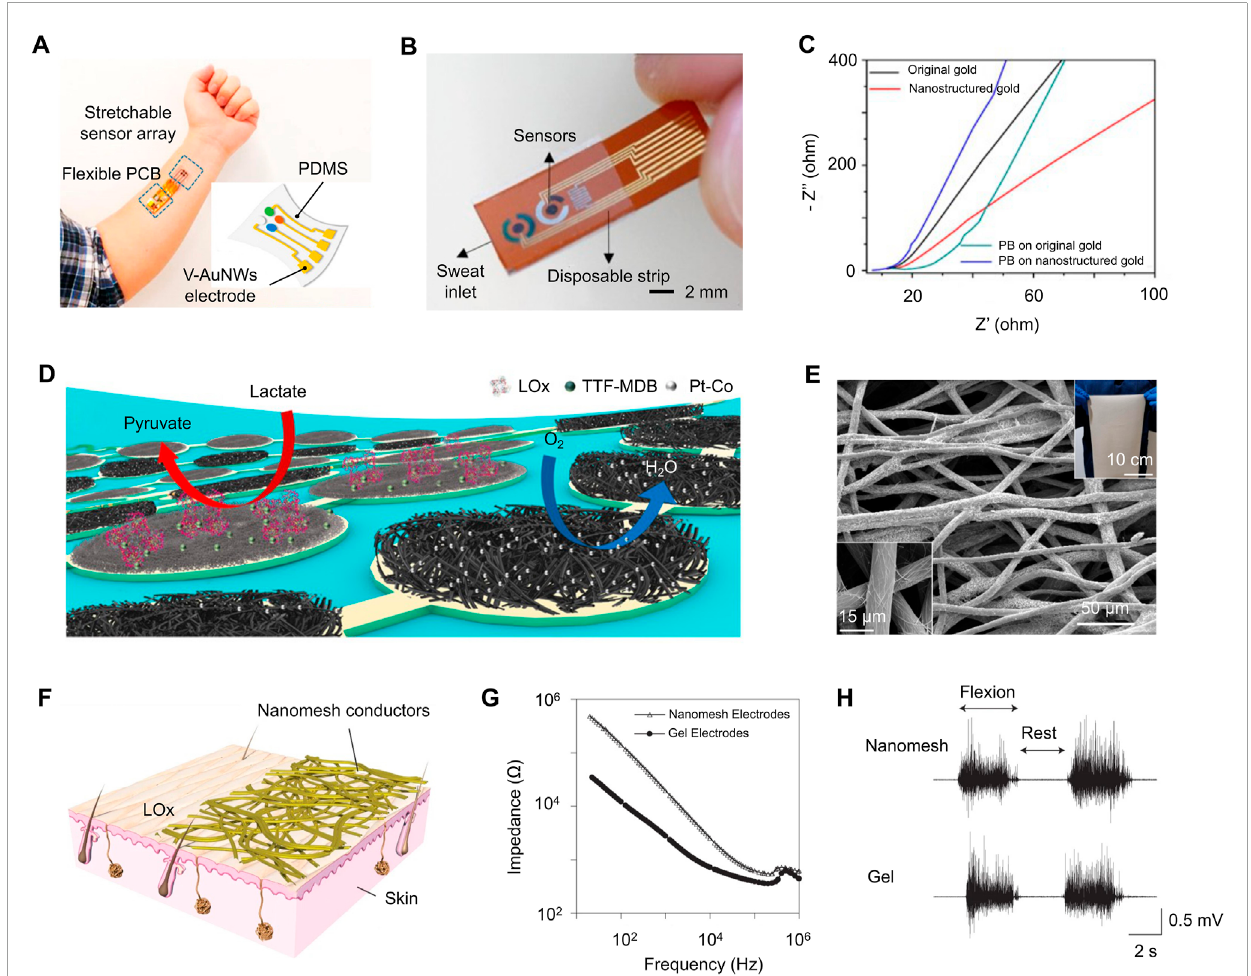
FIGURE 5 (A) An integrated wearable multiplexed sweat analysis device with AuNWs -based electrode array conforming on a subject’s wrist. (B) Wearable/disposable sweat monitoring strip with porous Au coating. (C) Nyquist plot of EIS of O-Au (black), N-Au(red), O-PB (green), and N-PB (blue). (D) Schematic of a soft biofuel cells array consisting of LOx-modified bioanodes and Pt alloy nanoparticle–modified cathodes. (E) SEM image of AgNWs-coated conductive microtextile. Insets: A large microfiber textile (top-right) and a magnified SEM image. (F) A schematic of the Au-coated nanomesh conductors. (G) Impedance of the skin/electrode interface. (H) Electromyogram signals were measured on the forearm while the wrist was flexed at 90° (two times) and at rest by both nanomesh and gel electrodes. [adapted and modified from (Chen et al., 2017; Lee et al.,